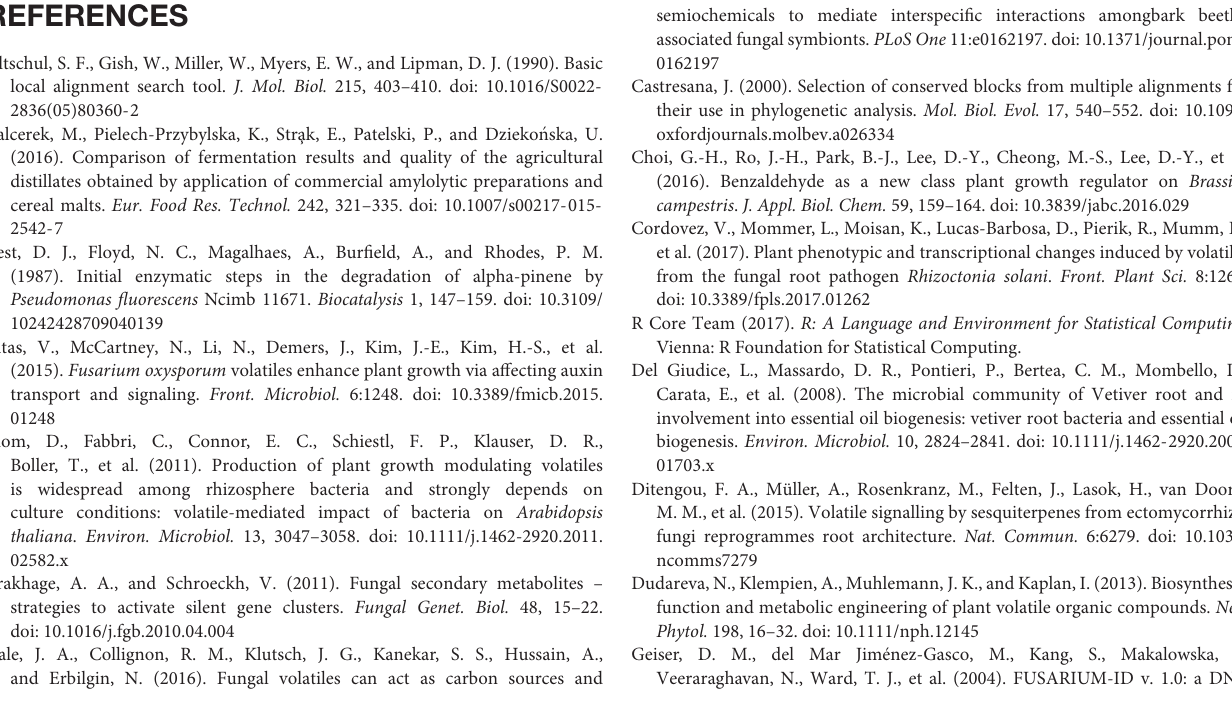
FIGURE S1 | Phylogenetic tree of Fusarium strains used in this study and reference strains. Phylogenetic tree of 27 Fusarium strains ( Table 1 ) and reference strains [FUSARIUM-ID database (Geiser et al., 2004)] based on tef-1 α sequences. Numbers at nodes indicates bootstrap values (1,000 replications). FIGURE S2 | The presence of Fusarium does not affect Arabidopsis root branching or leaf surface area. Bioassays were conducted as described in Figure 1 . No significant differences in leaf surface area or root branching (number of secondary roots) were observed between Arabidopsis seedlings exposed to VOCs from non-inoculated soil or Fusarium or Helotiales-inoculated soil (statistics: Kruskal-Wallis test, p ≤ 0.05). FIGURE S3 | Comparison the effect of substrate on the VOC profile of Fusarium . Cluster analysis of the VOC profile of seven Fusarium strains grown either on malt extract (3–4 replicates per strain) or soil (3 replicates per strain). A representative VOC profile for each strain was generated by considering only TAGs (VOCs) which consistently appeared in all replicates, and these representative profiles were used to compute the dendrogram presented here. Signal present in the respective controls (i.e., soil or pure malt extract) was removed. TAGs transformed into binary data (i.e., presence–absence) were used to generate a cluster tree using Jaccard similarity index. • represent nodes with ≥ 70% (1,000 bootstraps). FIGURE S4 | VOC profiles of Fusarium strain P1065 on malt extract and soil. The two upper chromatograms represent the VOC profile of strain P1065 on malt extract and the profile of the control (malt extract without fungus), whereas the two lower chromatograms illustrate the VOC emitted by the same fungus on soil (or the soil control). These results exemplify the influence of the medium (malt extract versus soil) on microbial VOC emission. VOCs were identified or tentatively identified as: (1) 1-hexanol; (2) 4-heptanone; (3) styrene; (4) 7-ethyl-4-noanone; (5) benzaldehyde; (6) 1,3,5-trimethylbenzene; (7) 5-methyl-2-furancarboxaldehyde; (8) 1-heptanol. FIGURE S5 | VOC profiles of soil samples at the end of the bioassay. Heatmap illustrating the concentration of 14 identified VOCs and 33 not identified VOCs in n = 3 replicates per fungal strain and highlighting that non-inoculated soil tends to have a higher concentration of VOCs compared to Fusarium -inoculated soil. DATA SHEET S3 | GC/MS data for non-inoculated and Fusarium inoculated